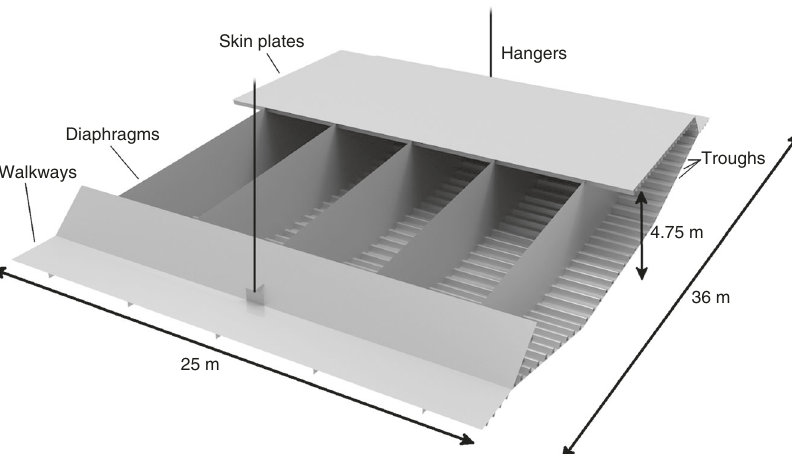
Fig. 2 Design concept and dimensions of the conventional girder. A single 25-m-long section of the continuous girder from Fig. 1 is shown with half of the top part removed to reveal the internal details of the